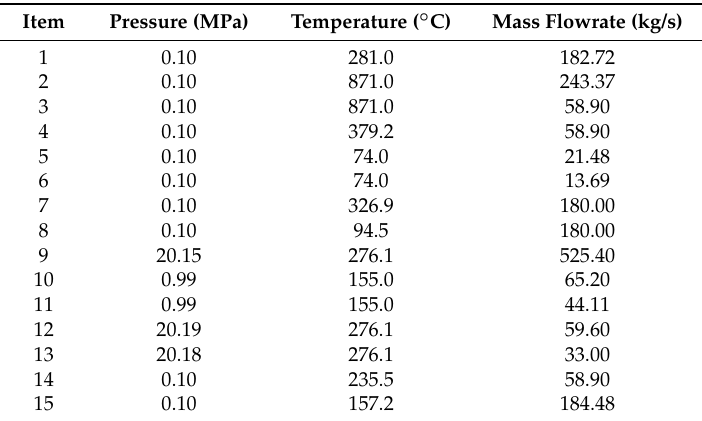
Table 6. Main stream parameters of the proposed system.